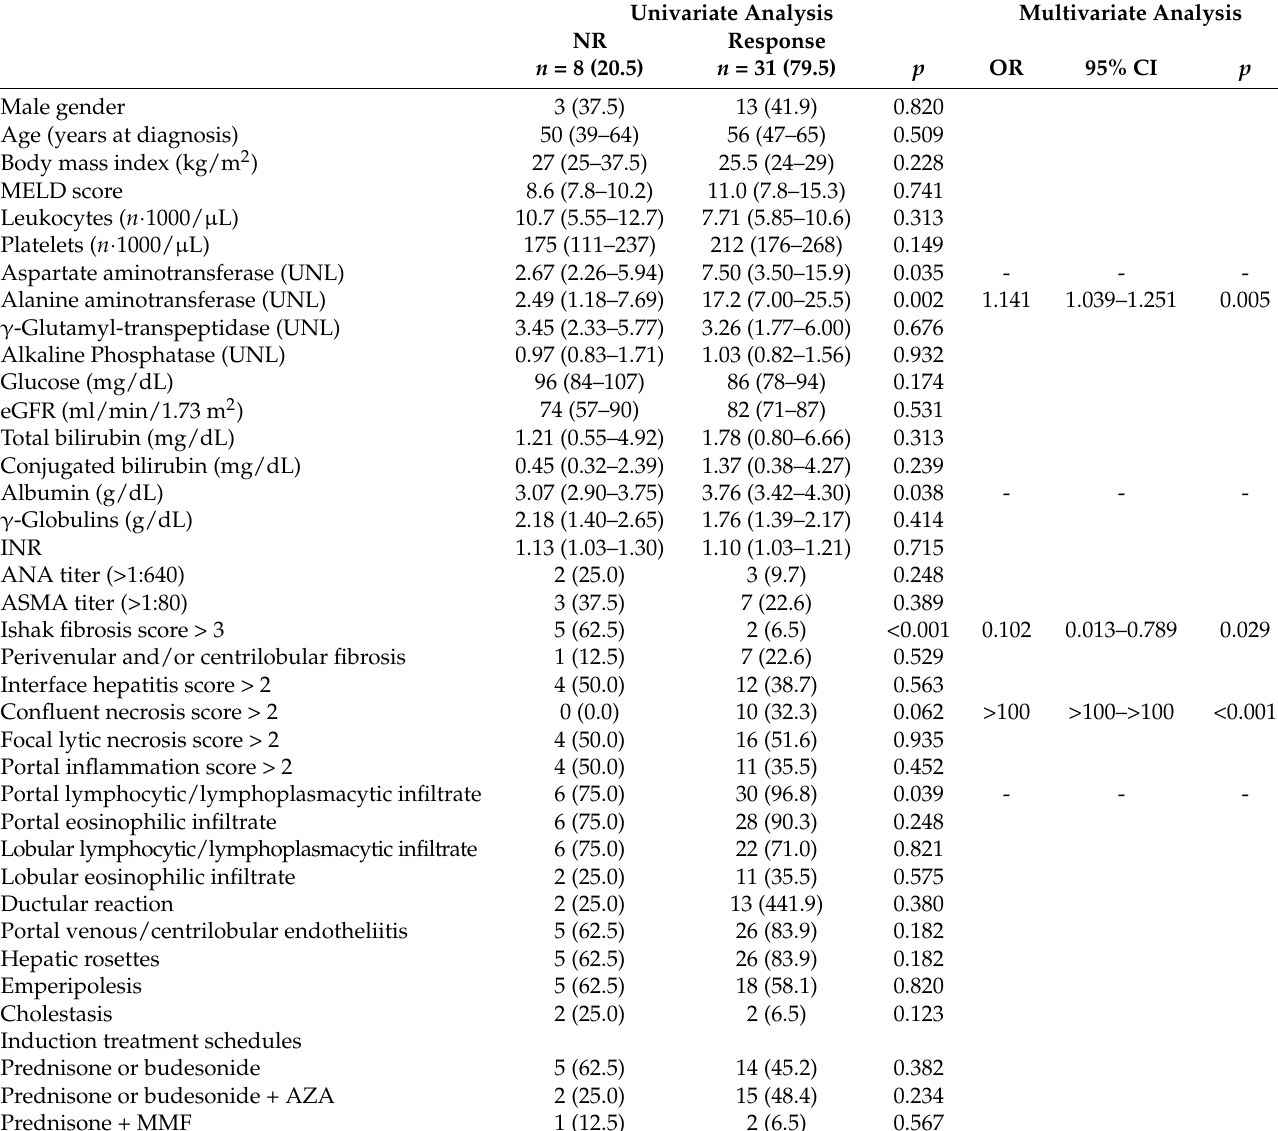
MELD: a model of end-stage liver disease; eGFR: estimated glomerular filtration rate; INR: international nor- malized ratio; ANA: antinuclear antibody; ASMA: anti-smooth muscle antibody; AZA: azathioprine; MMF: my-